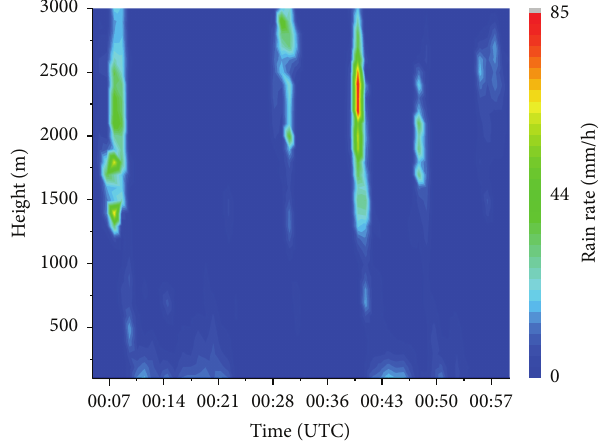
Figure 5: Rainfall rate registered by the MRR in the first 60 minutes of rain according to